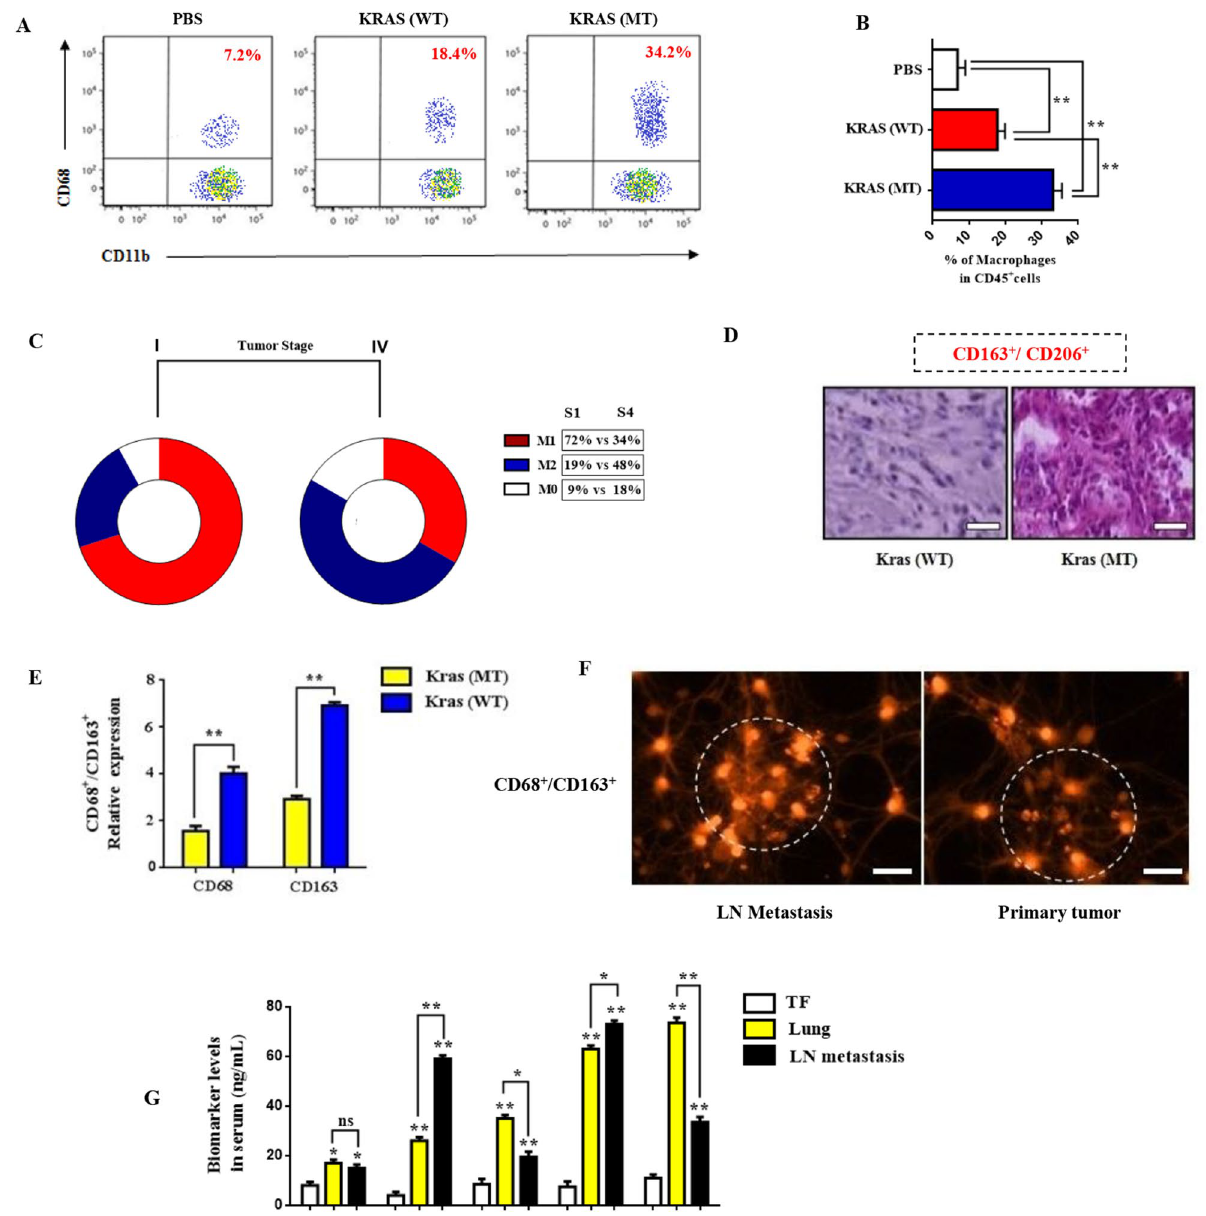
Figure 2. Intra-epithelial CD163 + /CD206 + M2 macrophages prompt Kras immunosuppressive chemoresistance. ( A , B ) Quantification of CD11b + CD68 + macrophages in Kras patient tissue samples using FACS analysis. The results represent the mean ± SD of three independent experiments. ( C ) Distribution percentage of macrophage subsets (M1/M2/M0) in lung tissues from primary Stage I and metastatic Stage IV patient groups. ( D , E ) Immunohistochemical analysis of CD68 + /CD163 + expression in Kras (WT) and Kras (MT) groups. The results represent the mean ± SD of three independent experiments. ( F ) Immunofluorescene analysis of CD68 + /CD163 + positive cells among intratumoral macrophages (magnification × 200). Images were captured using Carl Zeiss fluorescence confocal microscope. ( G ) Relative expression of M1/M2 biomarkers TNF-a, IRF4, IRF5, ARG1 and iNOS, in intratumoral and peripheral macrophage subsets isolated from PBMCS and tissue biopsies from tumor free (TF), LC and LN metastasis groups respectively. Data represent the mean ± SD of three independent experiments (*p < 0.05; **p < 0.01). Differences were considered statistically significant at p < 0.05. Statistically significant data are indicated by asterisks (*p < 0.05, **p <